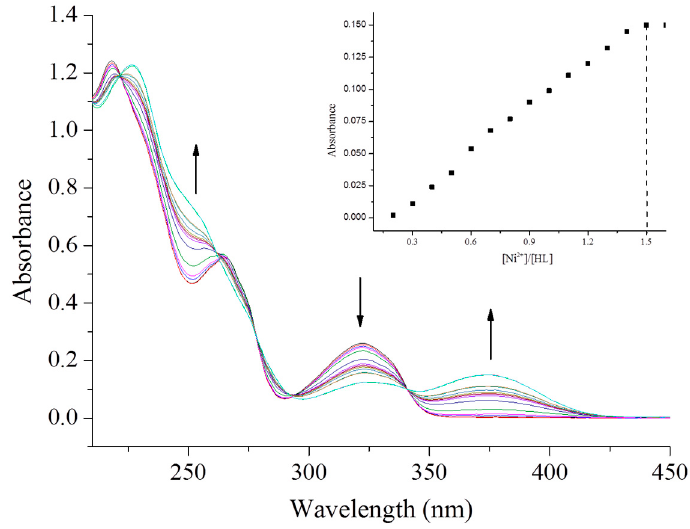
Figure 1. The UV-Vis titration spectra of the Ni(II) complex (cm − 1 ).